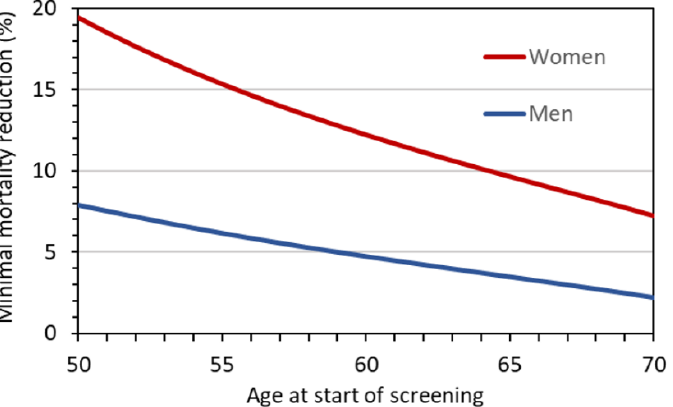
Figure 6. Reduction in lung cancer mortality that must be achieved to attain a benefit – risk ratio of at least 10 assuming annual screening across the given age intervals for a representative LDCT pro- tocol with CTDI vol = 1 mGy.